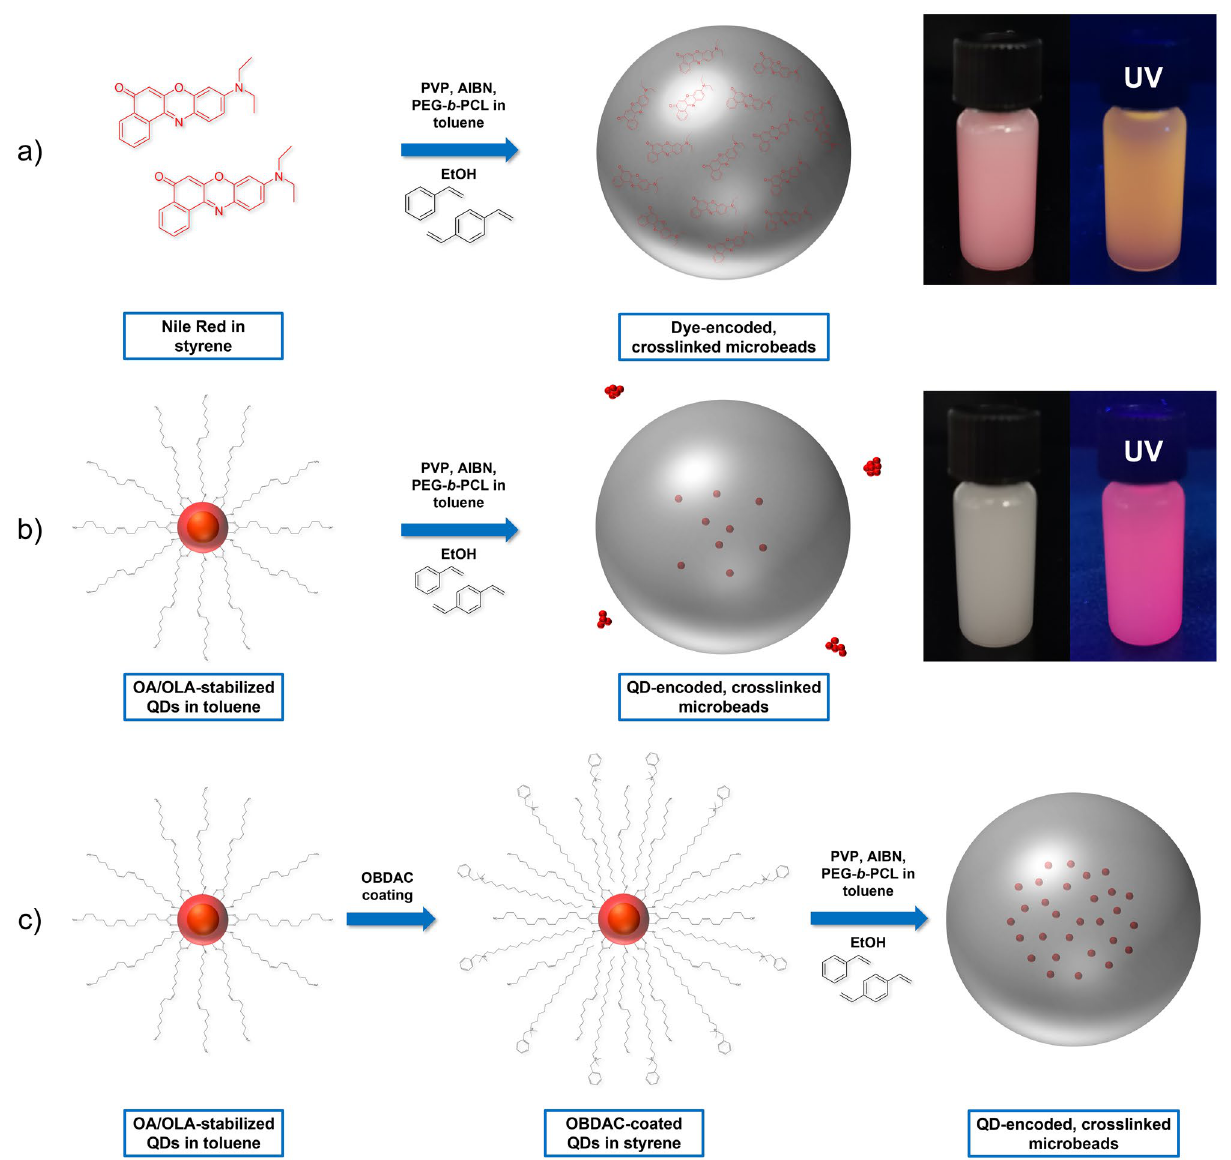
Figure 1. Schematic presentation of the synthesis routes employed for the preparation of the luminescent polystyrene (PS) microbeads, encoded with ( a ) Nile Red, ( b ) OA/OLA-stabilized CdSe/CdS-QDs without pretreatment, and ( c ) OA/OLA-stabilized CdSe/CdS-QDs, synthesized with the developed and optimized procedure, including the pretreatment of the QDs with the polymer-compatible ligand OBDAC. The photographs of the respective ethanolic bead dispersions were taken under day and UV